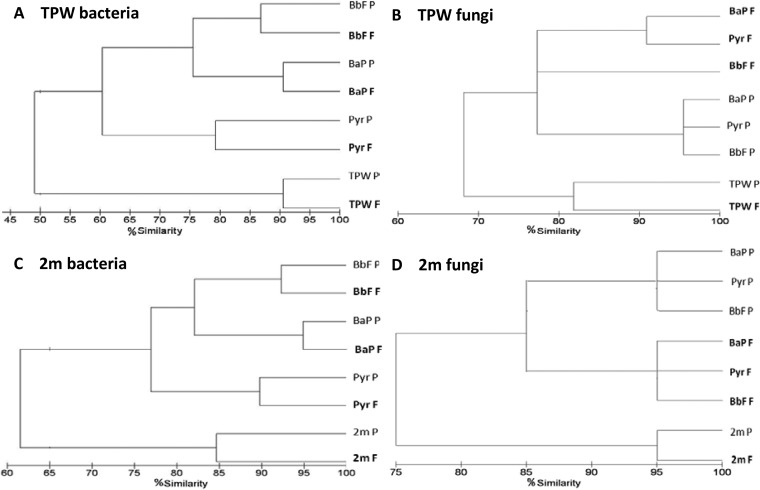
Cluster analysis illustrating similarities between bacterial and fungal community structures on day 33 of the biotransformation experiment on HMW-PAHs. (A) TPW bacterial community; (B) TPW fungal community; (C) 2m bacterial community; (D) 2m fungal community. P, planktonic community; F, filter community; TPW, TPW community with no added PAH; 2m, 2m community with no added PAH.